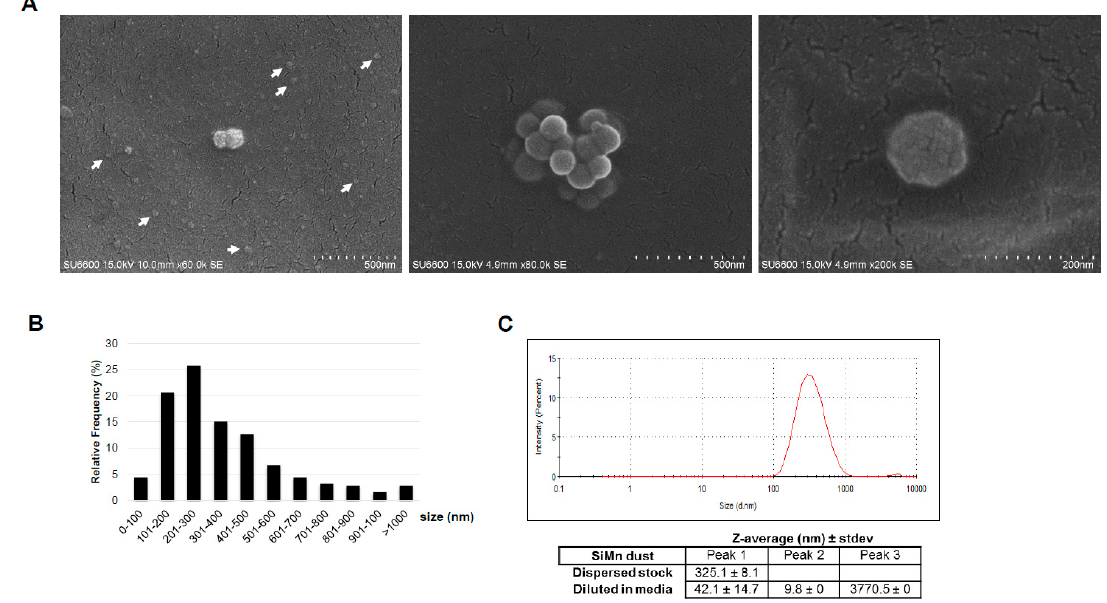
Figure 2. Characterization of dispersed SiMn dust. ( A ) A volume corresponding to 100 µg dust was taken from a 1 mg/mL stock dispersed in 0.05% BSA and filtered through a 47 mm Whatman Nuclepore polycarbonate filter with 15 nm pore size. The dust was investigated by SEM and representative images are shown. Arrows point to nano-sized particles that were difficult to visualize due to the platinum coating. ( B ) The diameter (nm) of the dust particles was measured and the relative frequency in percentage is shown for the different size groups ( n = 252). ( C ) Size distribution and average hydrodynamic diameter of the dispersed SiMn dust. One mL of the dispersed SiMn stock solution was used for DLS measurements to obtain the size distribution and average hydrodynamic diameter of the dust. 10 cycles were run. The graph showing the size distribution is representative of one measurement over 10 cycles. The Z-average from three independent dispersed batches is shown ± standard deviation (SD).